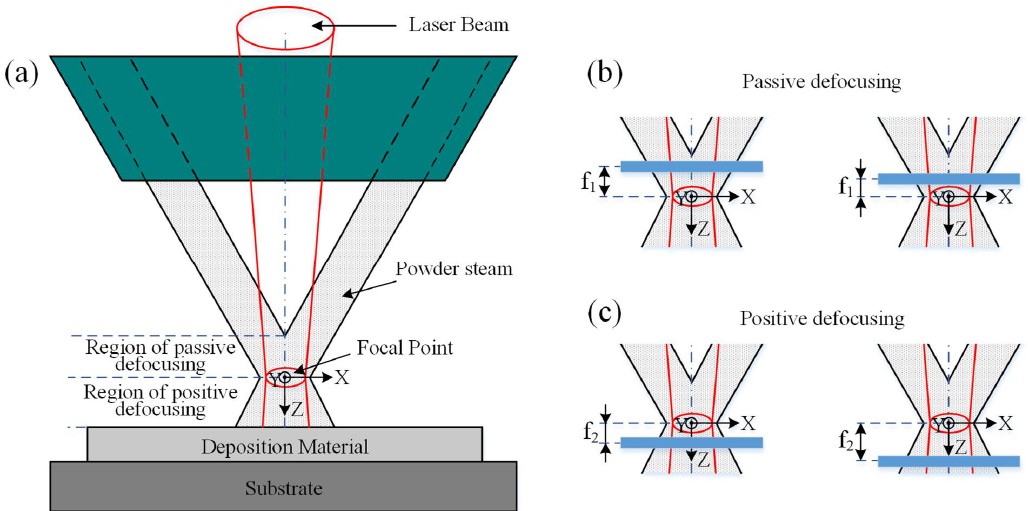
Figure 1. Schematic diagram of ( a ) relative position between the deposition surface and laser focus point, ( b ) passive defocusing, and ( c ) positive defocusing.